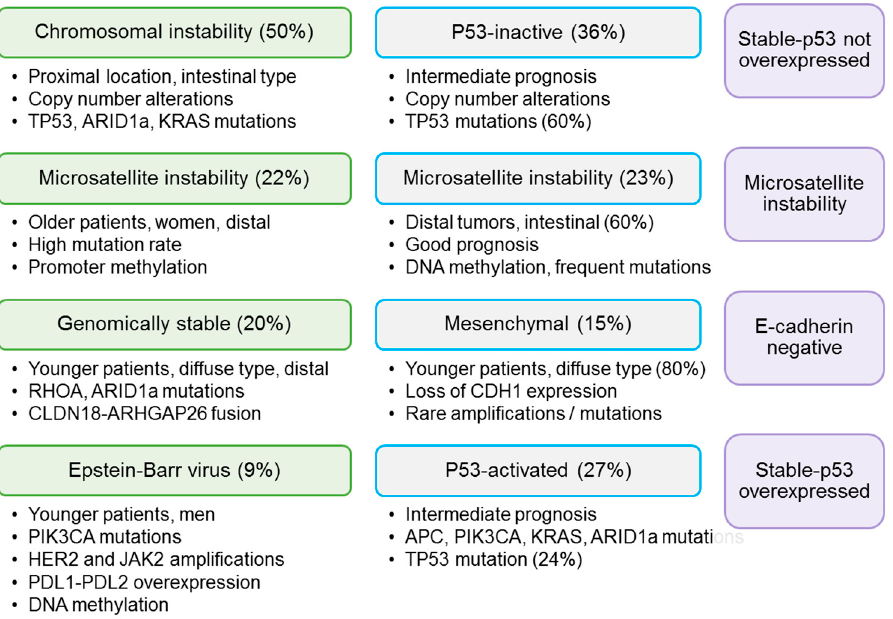
Figure 4. Molecular classifications of gastric cancer; from left to right: molecular subtypes as defined by The Cancer Genome Atlas Research Network, Asian Cancer Research Group and immunohistochemical-based classification.